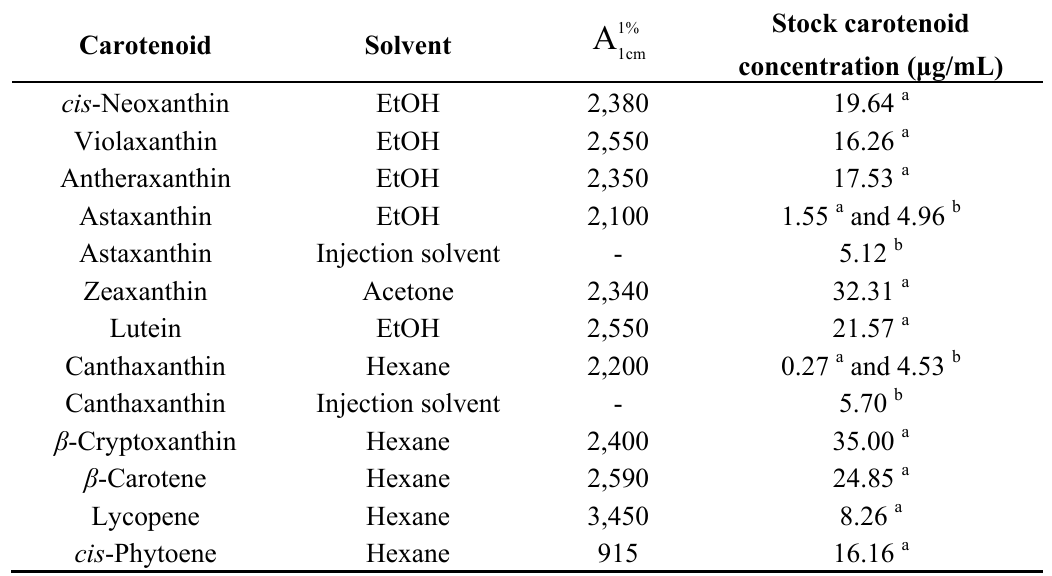
Table 4. Concentrations of carotenoid stock solutions used to build calibration curves.